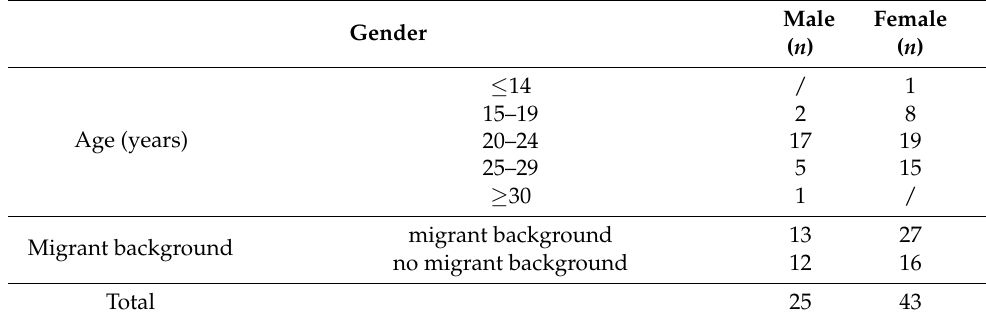
Table 1. Main characteristics of the participants in the Focus Group Discussions (FGD) ( N = 68).